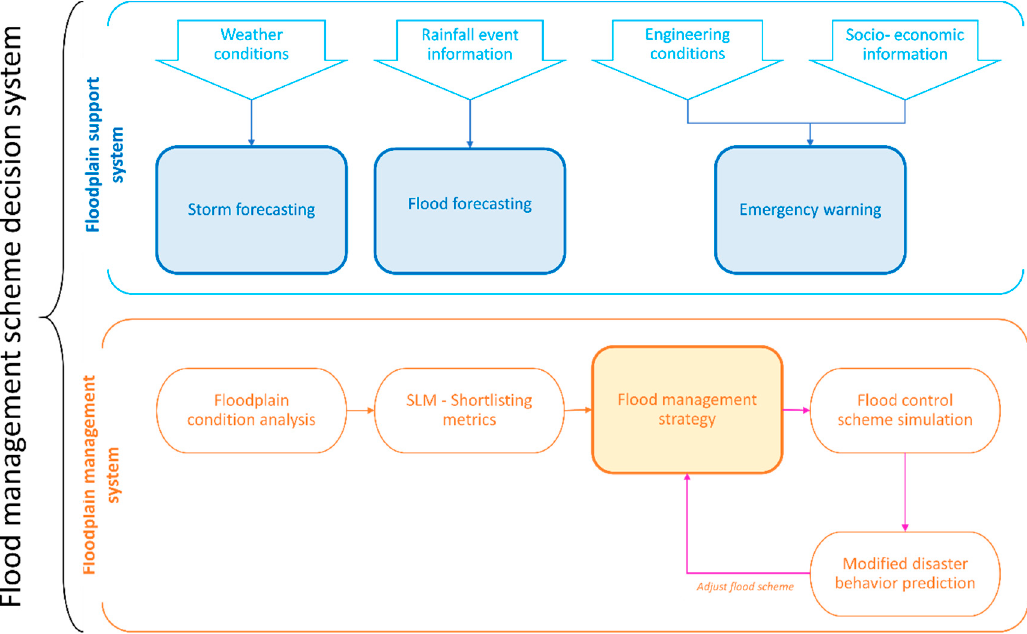
Figure 2. Flood management scheme design system consisting of the management and support components.